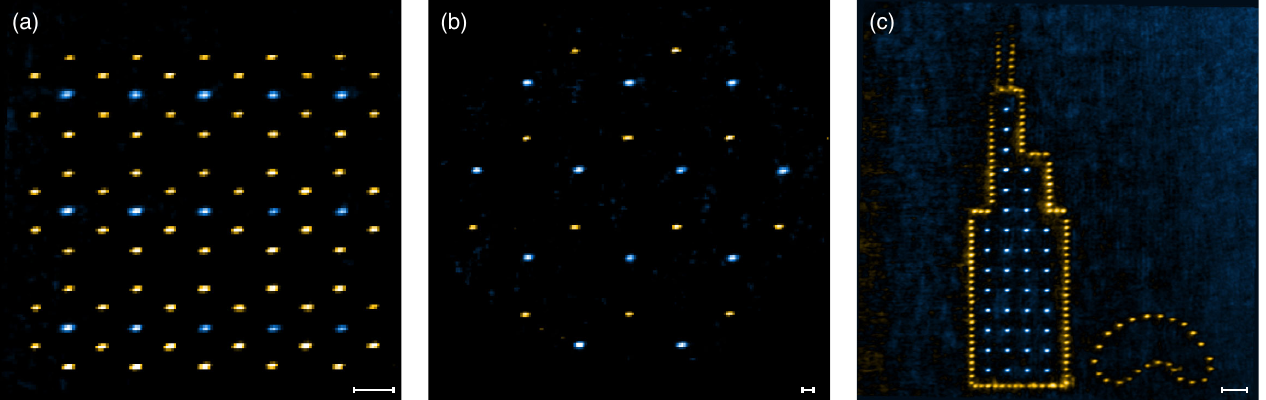
FIG. 5. Arbitrary geometries with dual-element arrays. Averaged fluorescence images for arbitrary array shapes with Cs in SLM trap sites (yellow) and Rb in AOD trap sites (blue). Scale bars indicate 10 μ m. (a) A Rb-dressed, Cs hexagonal lattice. (b) A bipartite honeycomb lattice. (c) Chicago landmarks: the Sears Tower and The Bean (Cloud